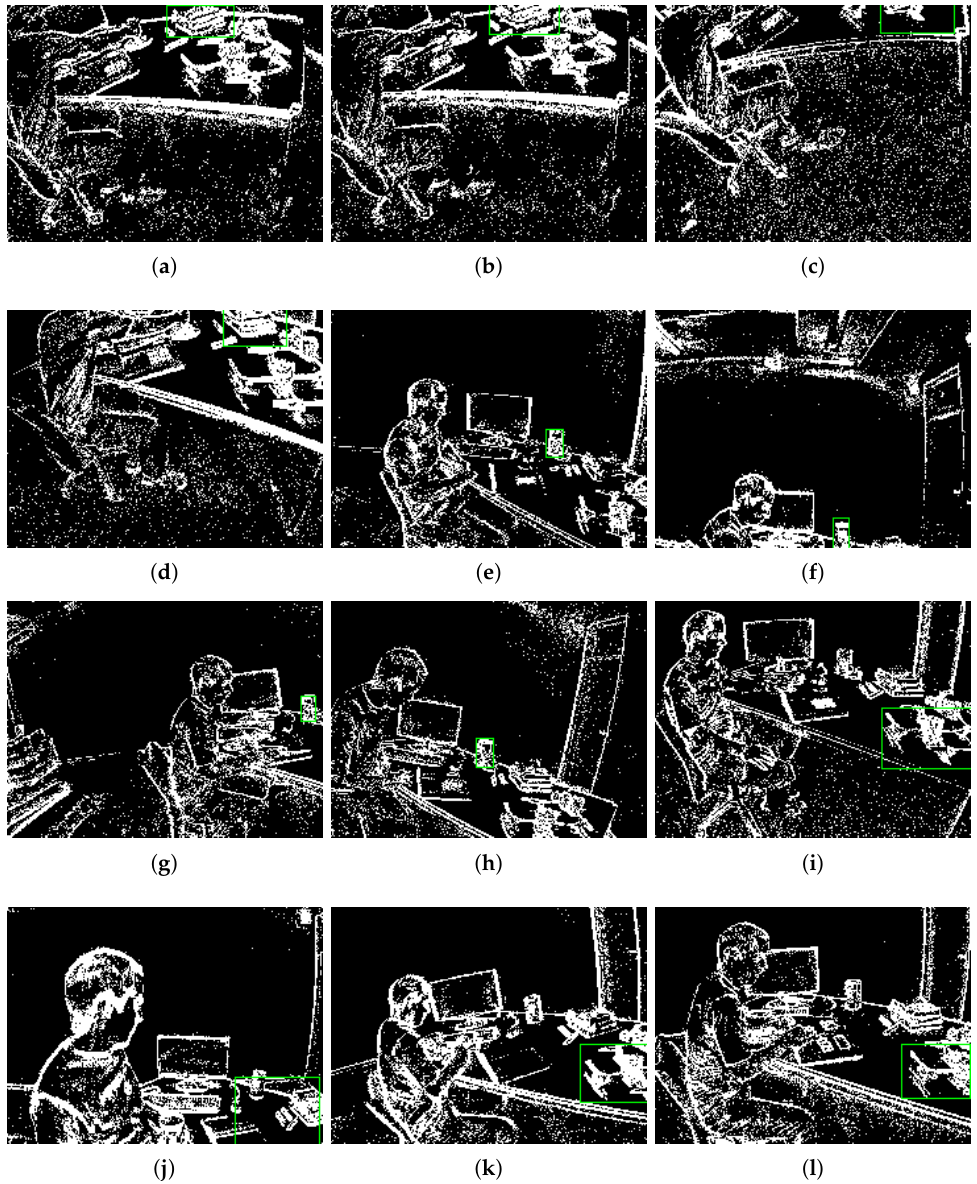
Figure 6. Tracking objects of different shapes and sizes. Each row shows the tracking of a single object; ( a – d ) show the tracking results of the book; ( e – h ) show the tracking results of the cup; ( i – l ) show the tracking results of the drone. It is shown here that our method can overcome the challenges of dramatic scene changes, object out of view, etc., and has good